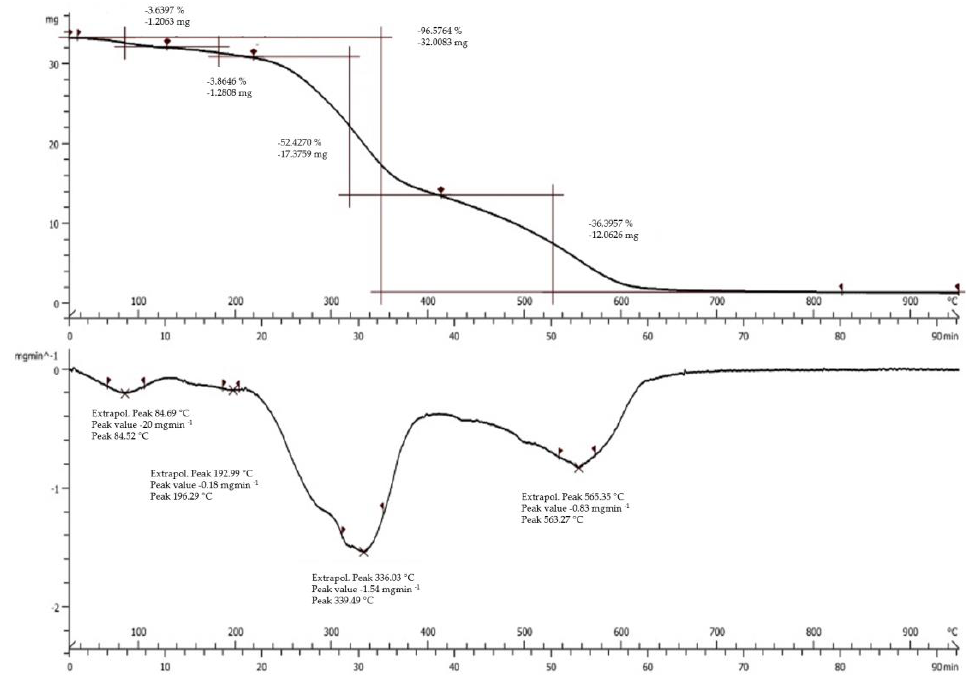
Figure 3. TGA ( top panel ) and DSC ( bottom panel ) profiles of SD crickets.